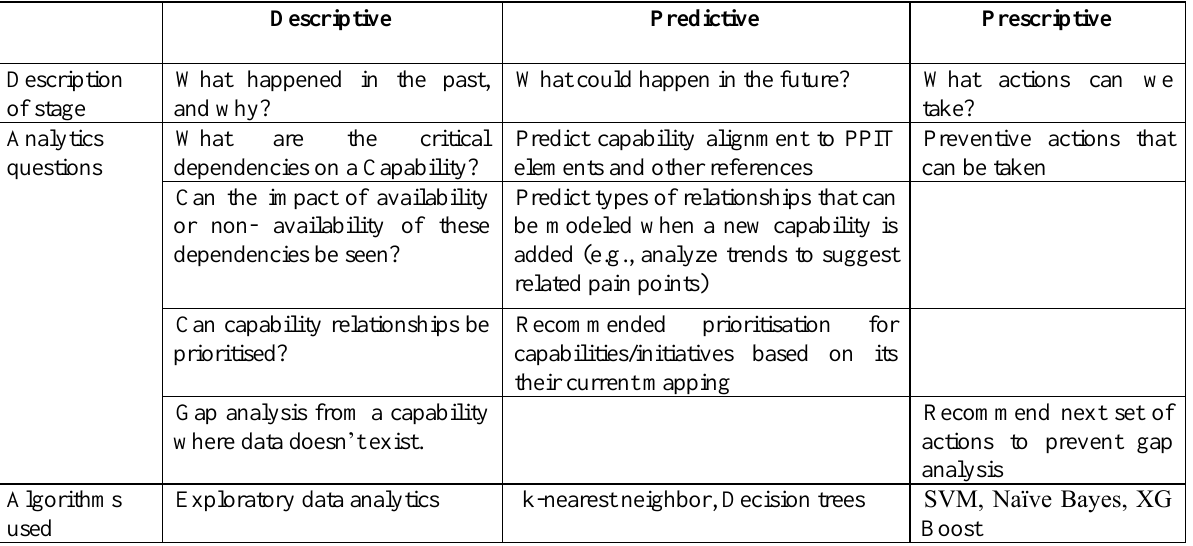
Table 4. Analytics questions for